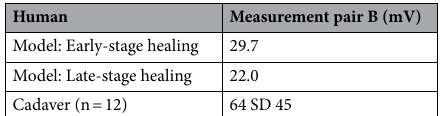
Table 1. Summary of electric potentials reaching fracture site in humans.